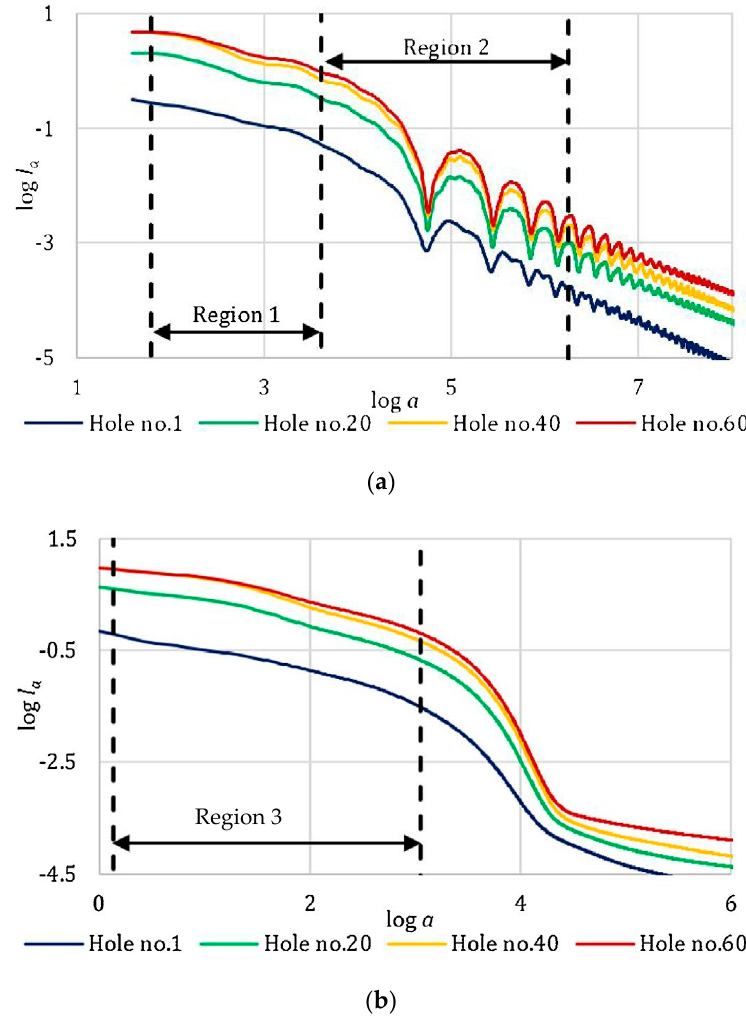
Figure 16. Regularization analysis curves: ( a ) rectangular kernel; ( b ) Gaussian kernel [33].